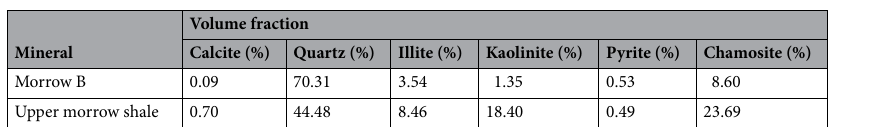
Table 1. Volume fraction of FWU minerals determine by ELAN